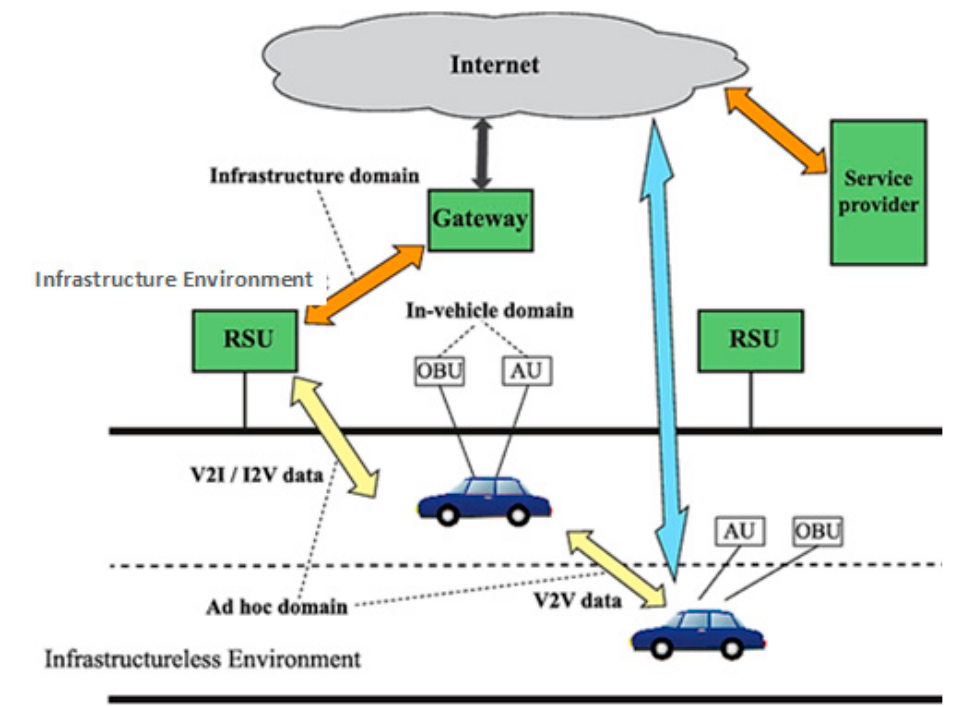
Figure 1. VANET structure for AU, OBU, and RSU [2].